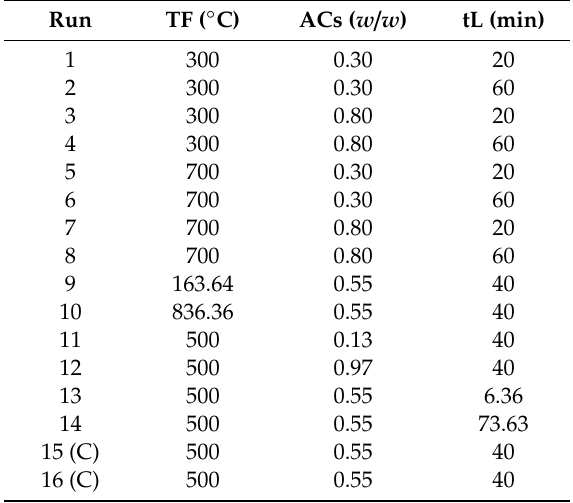
Table 3. Central composite design—mathematical modeling